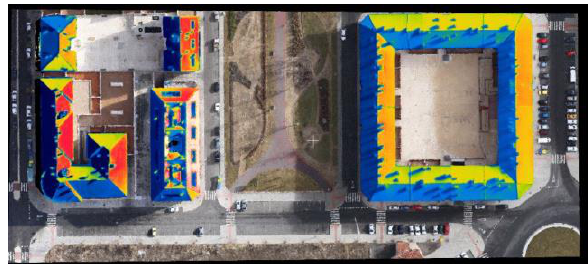
Figure 4: Example of 3D point cloud (2.179.610 points) generated from images captured with the RGB camera. Area: 23040m 2 . Resolution: 100 points/m 2 .